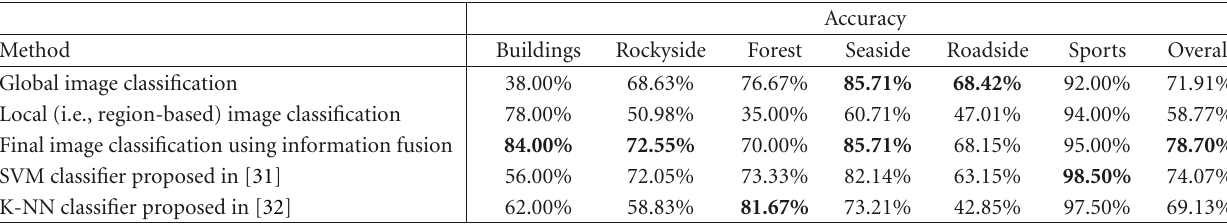
Table 3: Subdomain detection